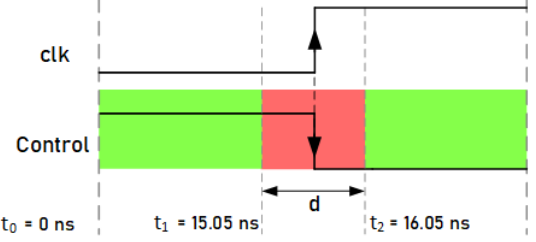
Figure 13. Representation of the range where the change in the control signal can cause fault